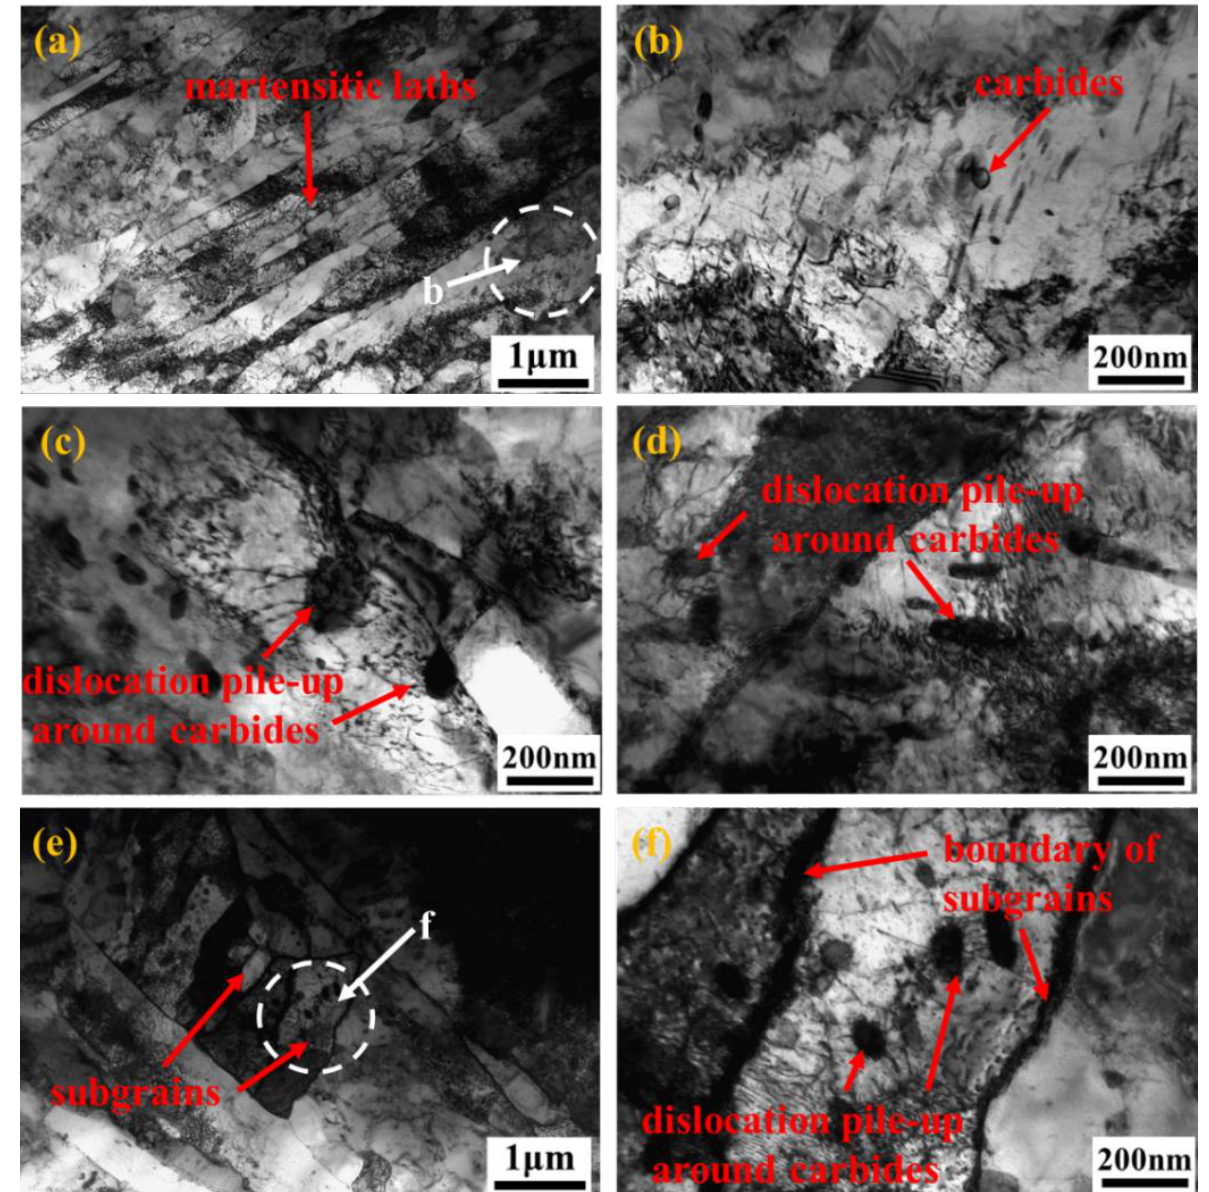
Figure 6. The typical TEM microstructures of the as-received and the LCF damaged BM specimens with different strain amplitudes: the as-received specimens ( a , b ) was the local enlargement of ( a ), the LCF damaged specimens with the strain amplitude of ±0.3% ( c ), ±0.5% ( d ), ±0.8% ( e , f ) was the local enlargement of ( e ).